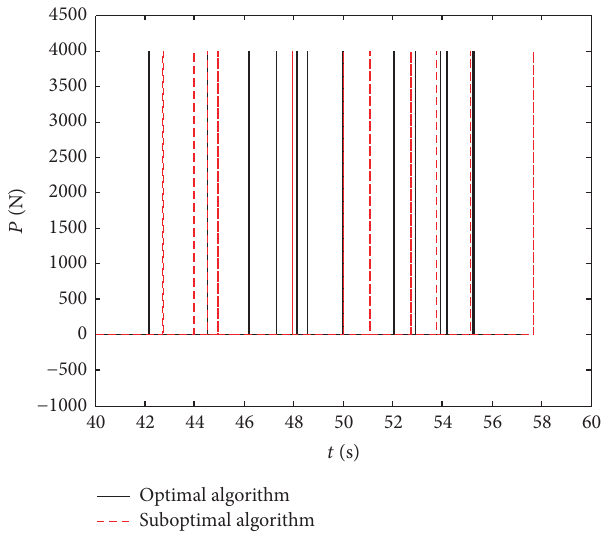
Figure 12: History between 𝑃 and 𝑡